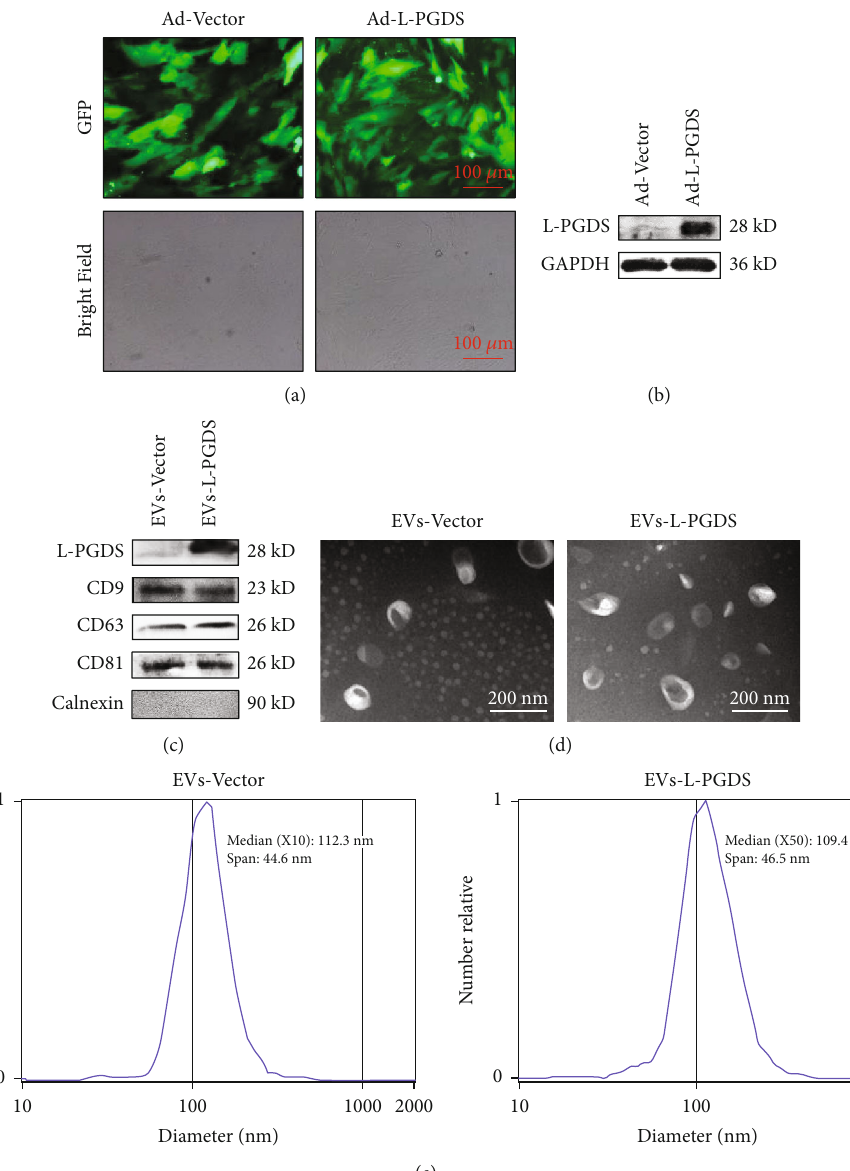
Figure 2: Ad-L-PGDS-modi fi ed huc-MSCs packaged L-PGDS into secreted EVs. (a) Representative fl uorescence images of GFP in huc- MSCs after treatment with adenovirus for 24h ( × 100). (b) Western blot for the expression of L-PGDS in adenovirus-transfected huc- MSCs after 24 h. (c) Western blot for the expression of EV markers CD9, CD63, and CD81 and the expression of L-PGDS in EVs. (d) TEM for the morphology of EVs. (e) NanoSight for the size of EVs. Abbreviations: TEM: transmission electron